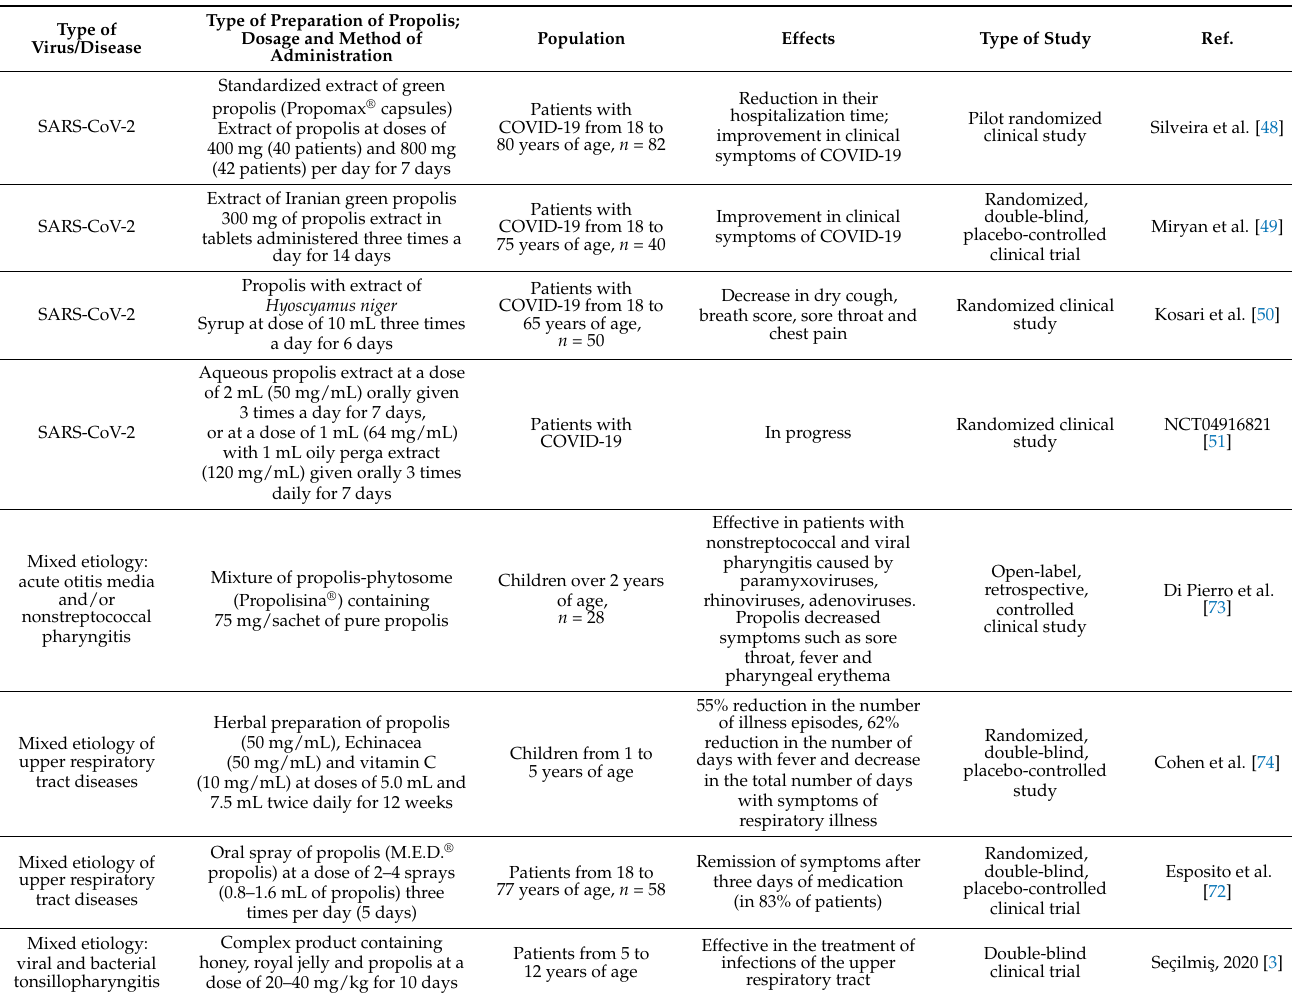
Table 2. Summary of antiviral activity of propolis against viral respiratory diseases based on clinical